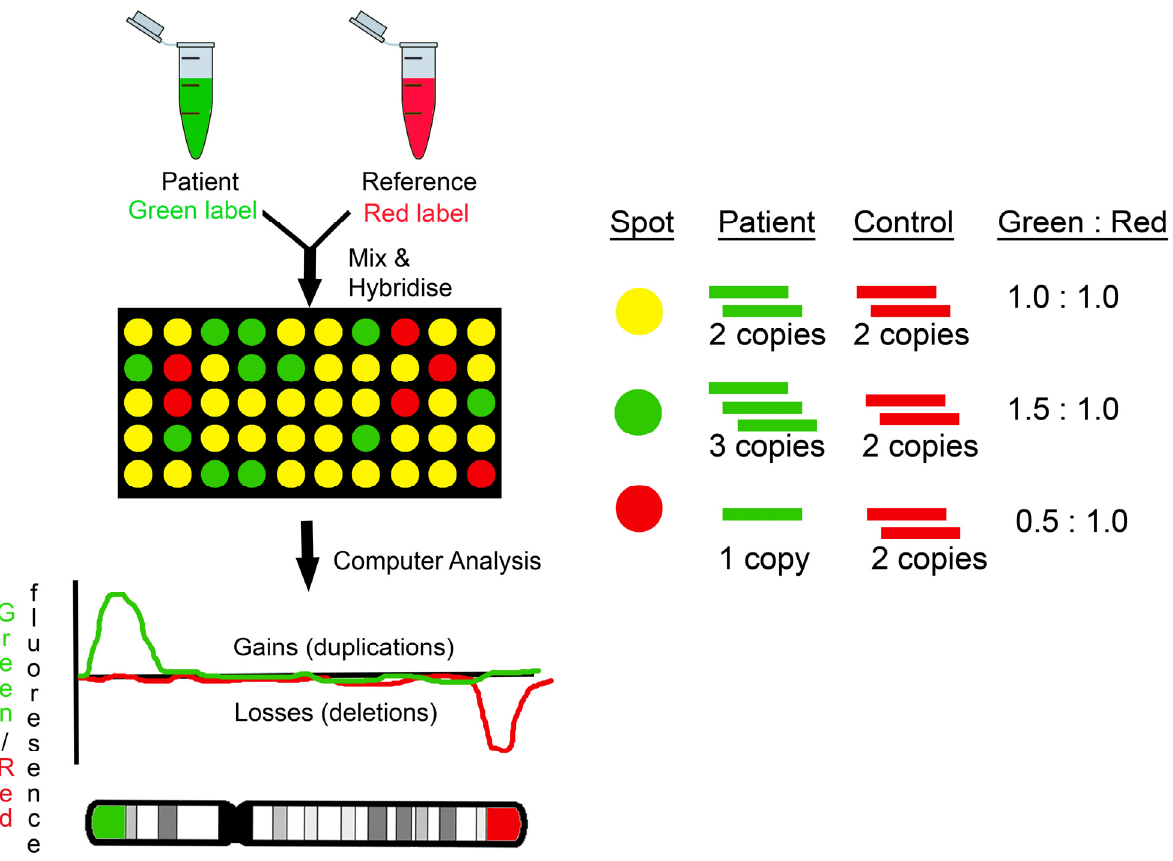
Figure 1. Comparative Genomic Hybridisation (CGH)